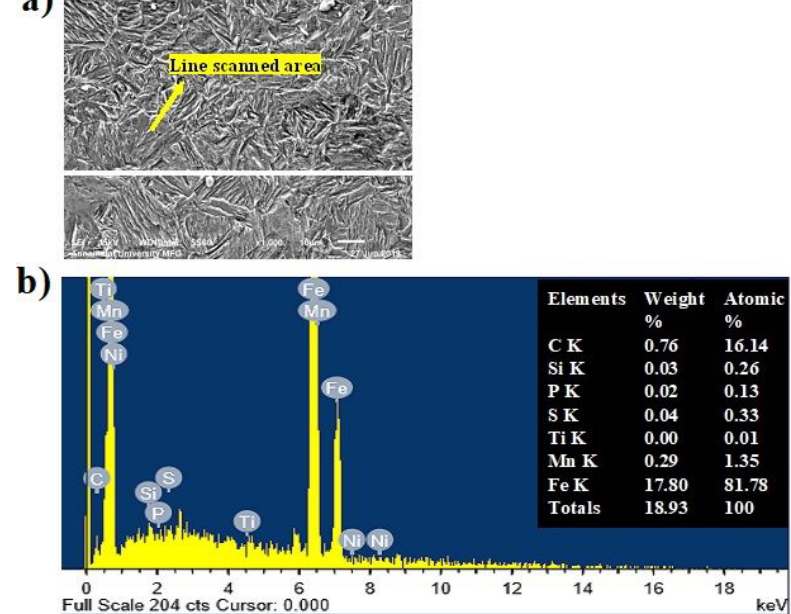
Figure 14: EDS line scan analysis of weld nugget: a) Line scanning region; b) EDS